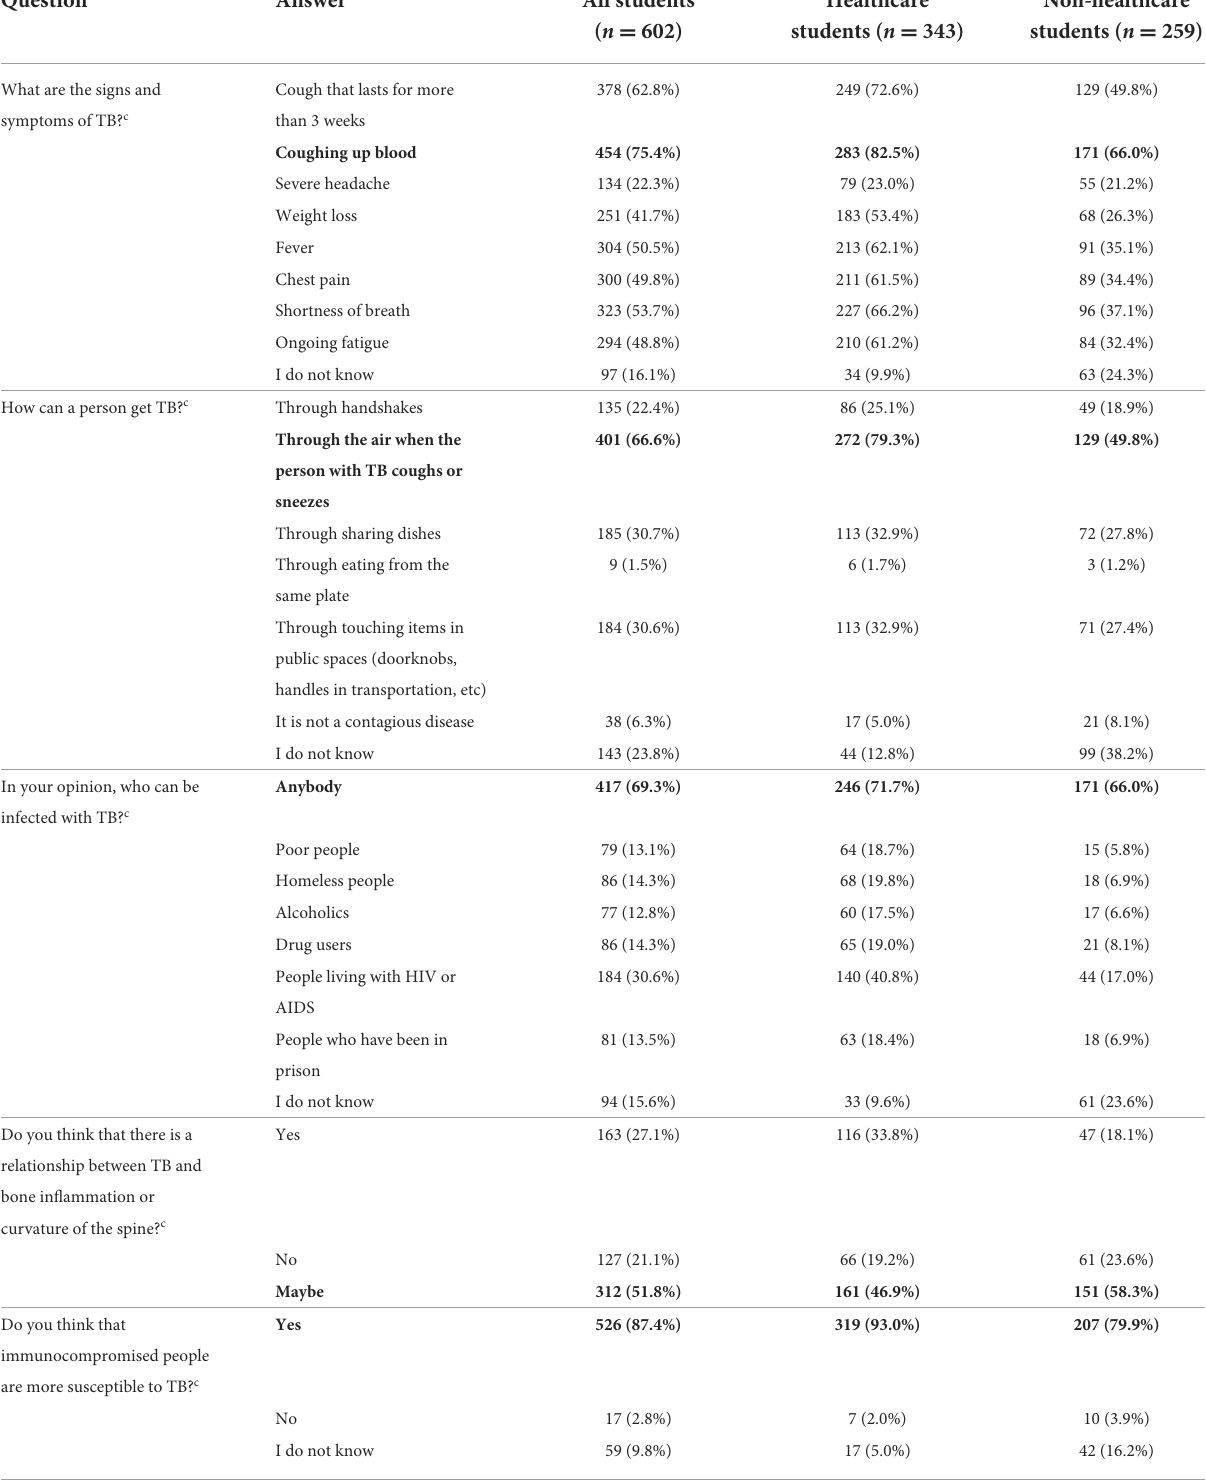
TABLE 2 Knowledge of TB symptoms, transmission routes, and risk groups a